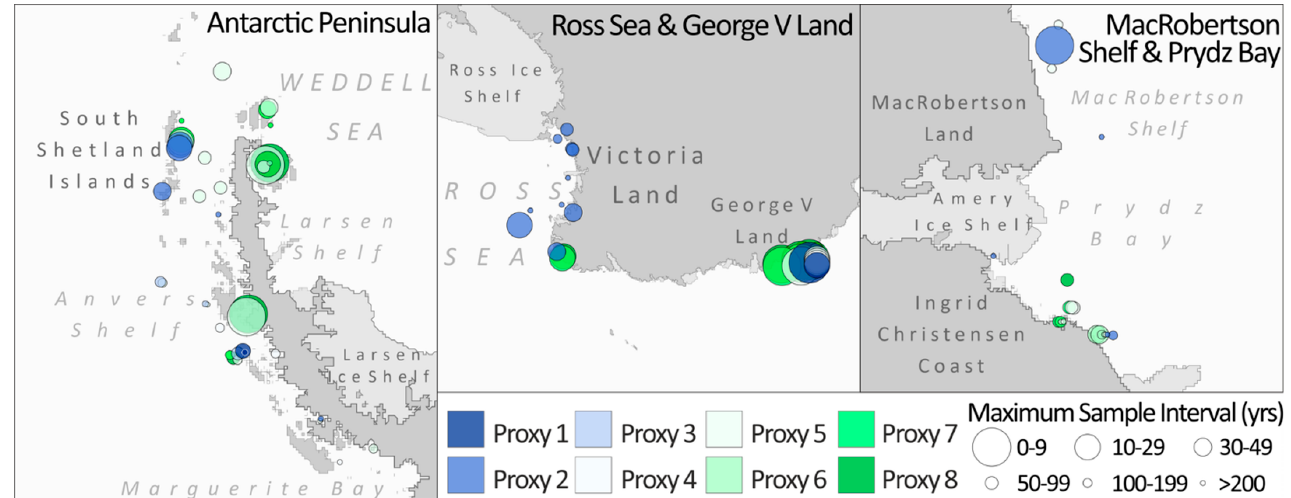
Figure 10. Maps of regions with greatest density of sea ice records from marine sediment cores, showing the diversity of proxy types and sample resolution. The symbol size reflects the resolution of the record and the color of the symbol indicates the proxy type (see Tables 1 and 3).